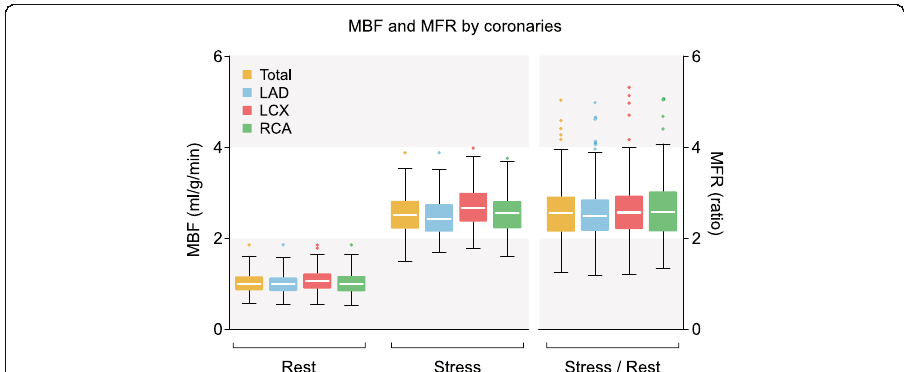
Fig. 2 MBF and MFR divided by coronaries. Boxplot with Tukey whiskers, dots are outliers. MBF = Myocardial